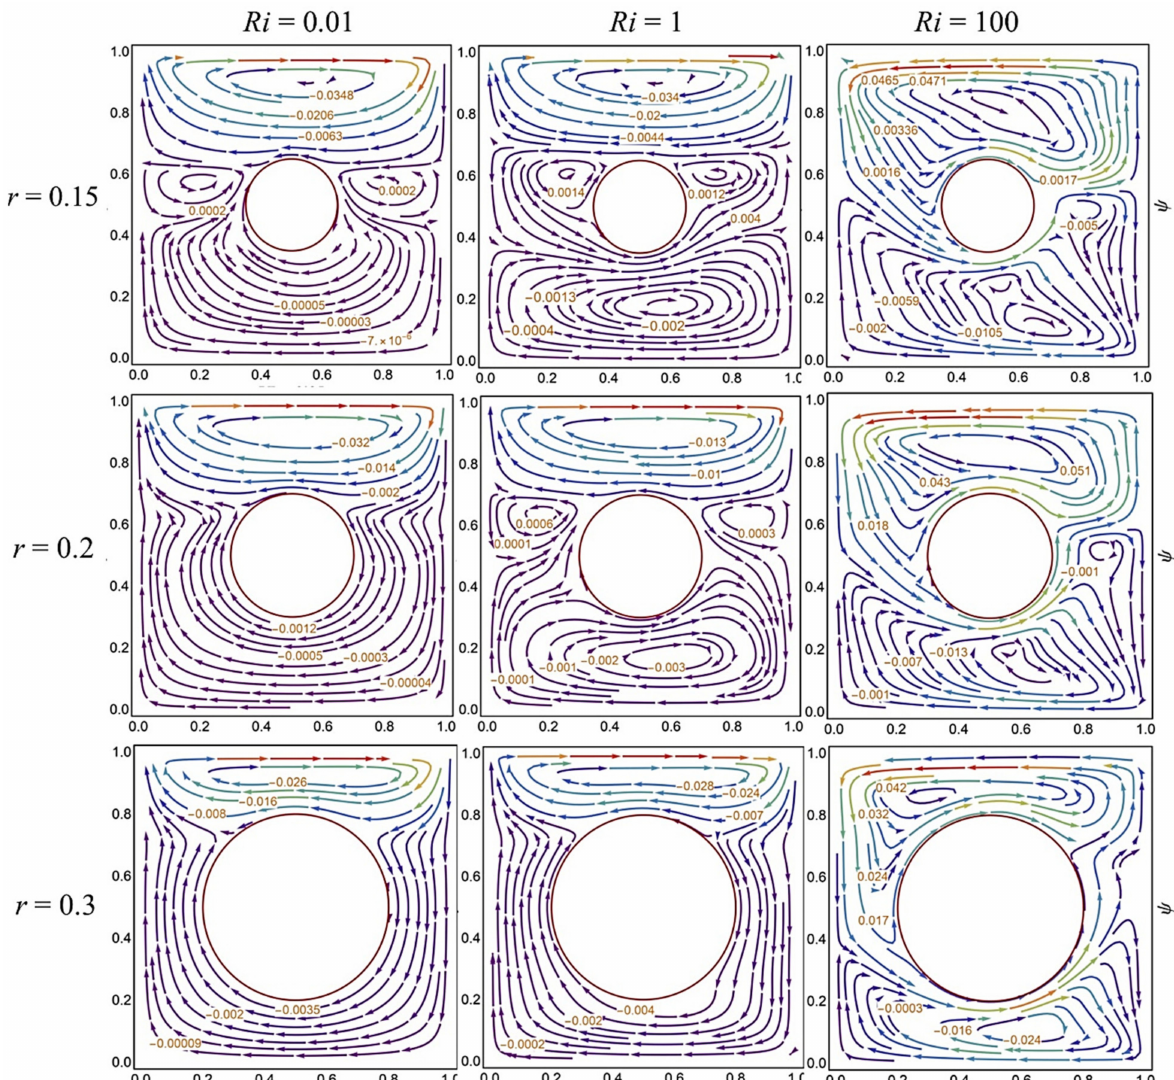
Figure 3. Streamlines pattern at various radii of center heater and Ri while the other parameters φ hnf = 0.02, Ha = 50, Re = 100, α = 45 ◦ , and β = 0 ◦ are kept